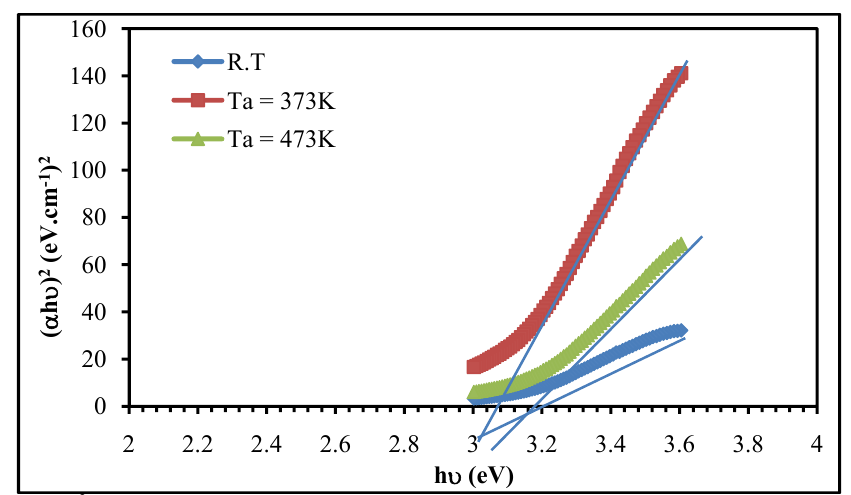
Fig. 5: ( α h ʋ ) 2 versus photon energy of incident radiation for as-deposited and annealed NiPcTs thin films